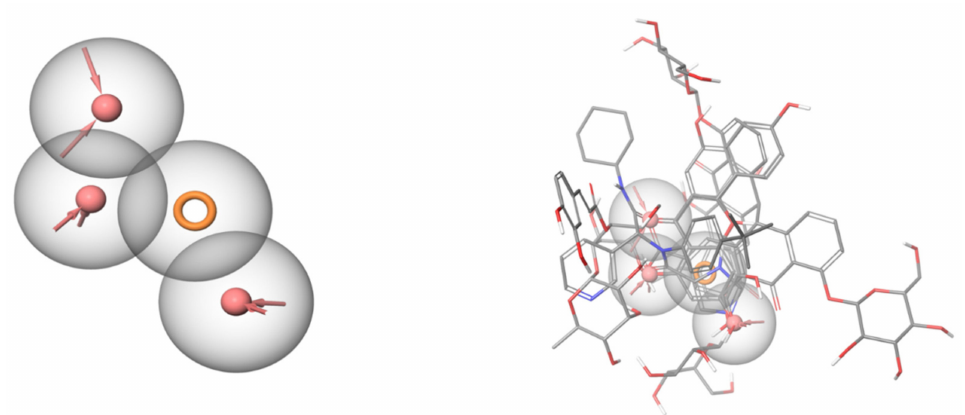
Figure 7. Common feature pharmacophore (left) generated using the active hits and the co-crystallized ligand. Red areas are acceptor features, and the orange ring is an aromatic ring feature. The active hits are aligned over each other (right) and mapped over the common feature pharmacophore. All the shown compounds map well to the features of the